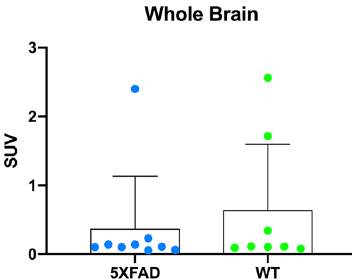
Figure 3. Whole brain [ 99m Tc]HMPAO SPECT perfusion measured via a standardized uptake value (SUV) in 5XFAD (blue) and WT (green) mice at 11.5 ± 0.2 months of age. No significant differences in whole brain perfusion were observed between 5XFAD (0.372 ± 0.762) and WT (0.640 ± 0.955) mice (p = 0.536). Individual subjects are represented by colored circles and the bar plot indicates Mean ±